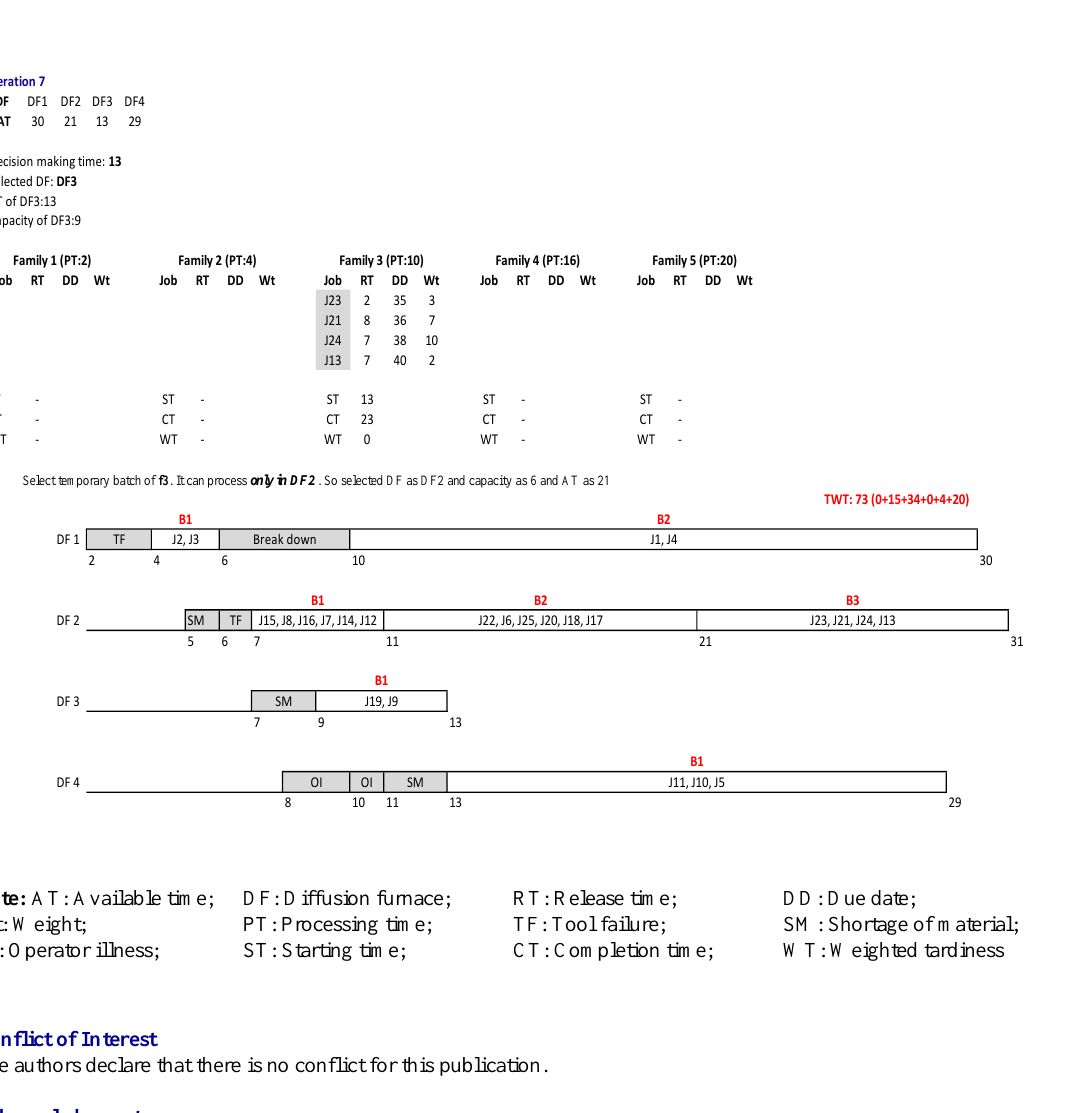
1483 | Vol. 6, No. 6,